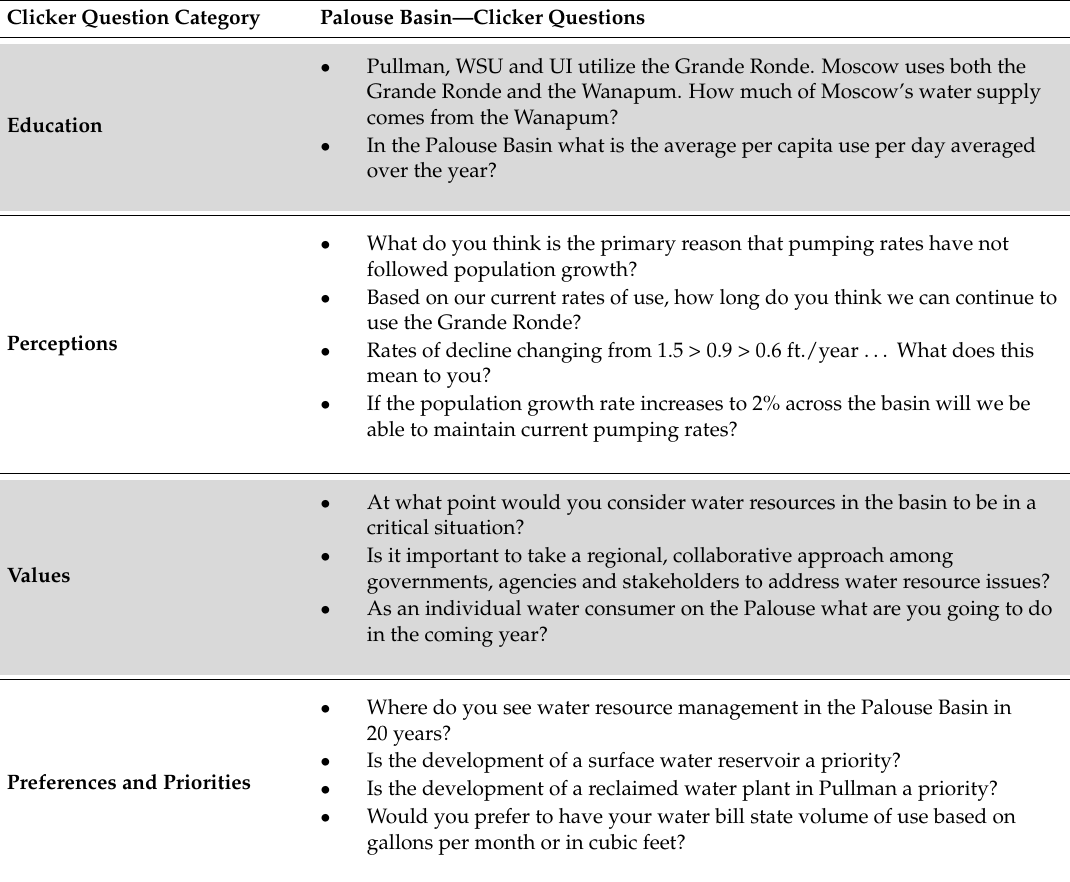
Table 2. Partial list of clicker questions presented to participants at the Palouse Basin Water Summit between 2013 and 2015 (for additional questions please contact authors). Multiple-choice answer alternatives to six of these questions and the participant’s responses are listed in Table 4.